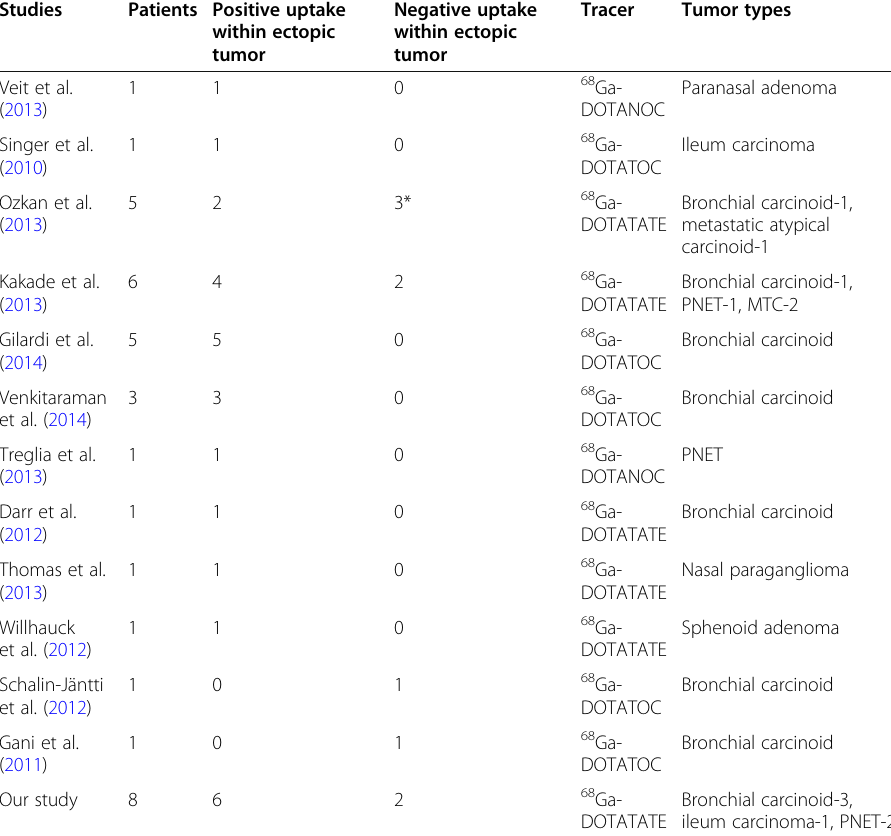
Table 3 Study of ectopic ACTH PET-CT scan with 68 Ga-DOTA peptides Studies Patients Positive uptake Negative uptake within ectopic within tumor